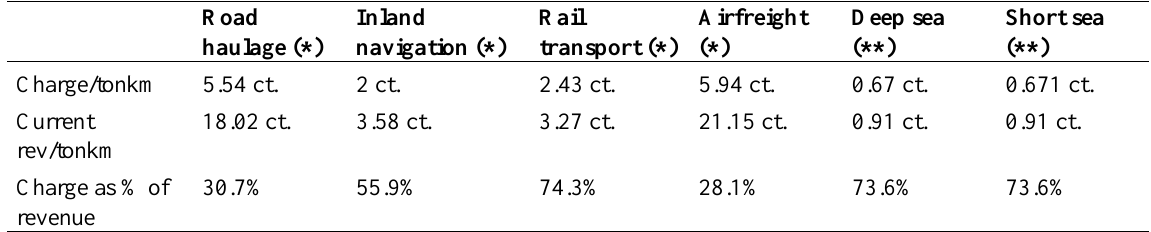
Table 6. Charges in scenario 1 and current revenues in (cid:128)-cent per ton-kilometer 8